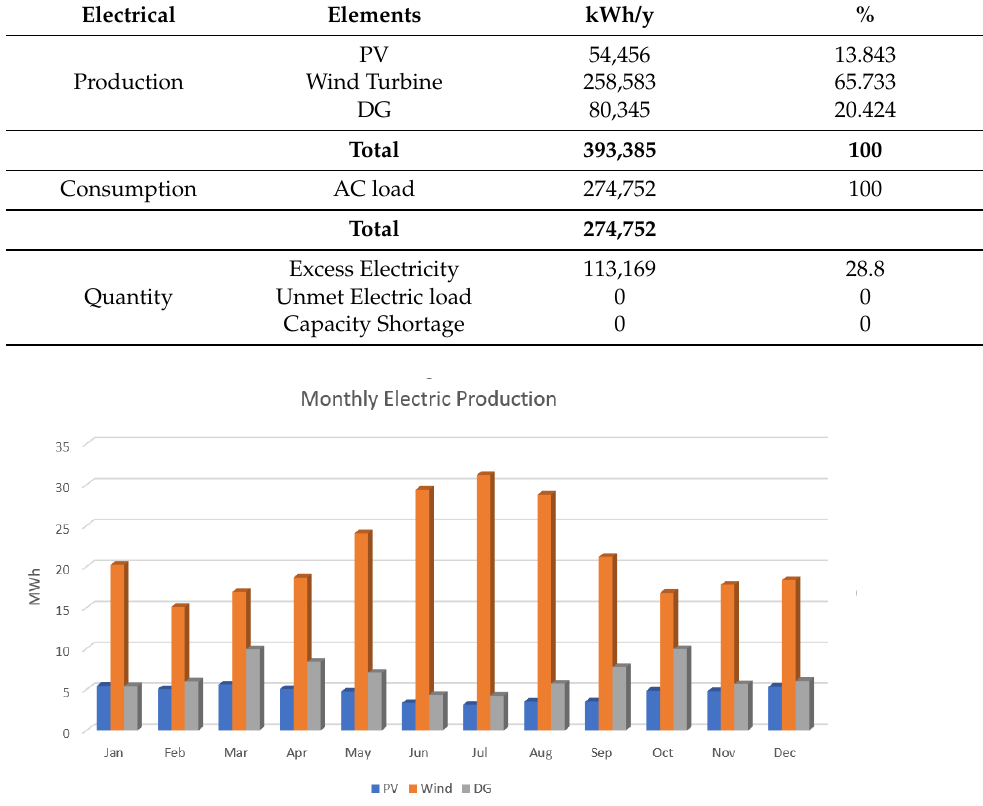
Figure 11. PV/Wind/Battery/DG-based electricity production throughout the